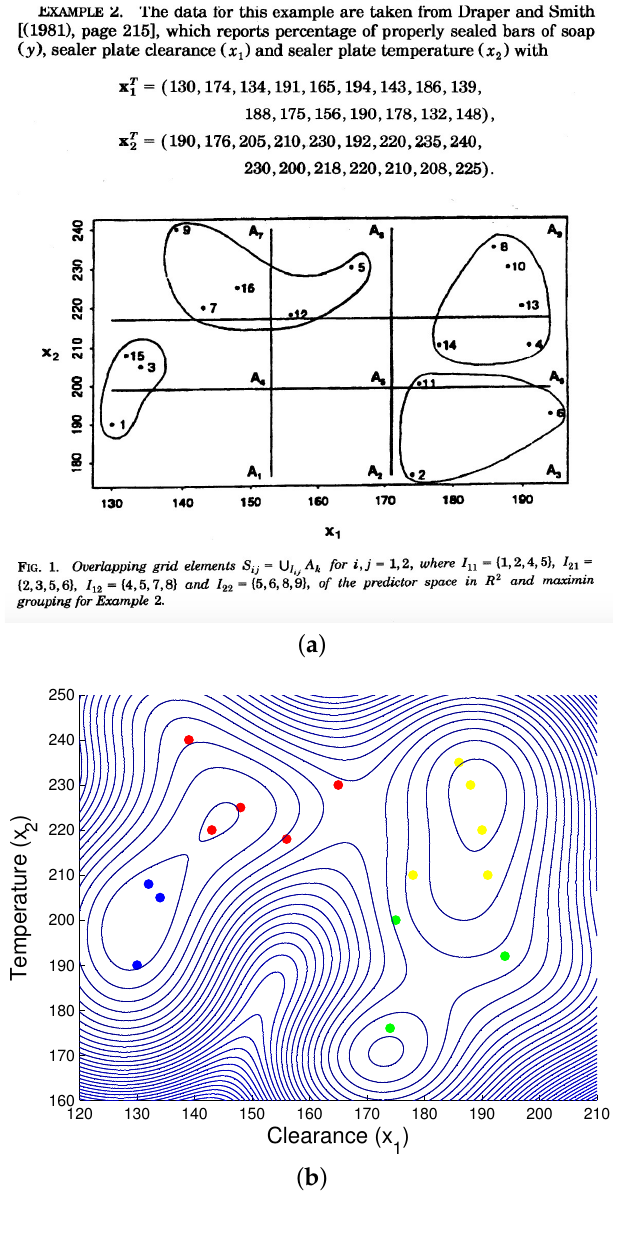
Figure 6. Smith and Draper data. ( a ) Reproduction of P. 1425 of [49]; ( b ) Quantum Clustering (QC) σ = 18 √